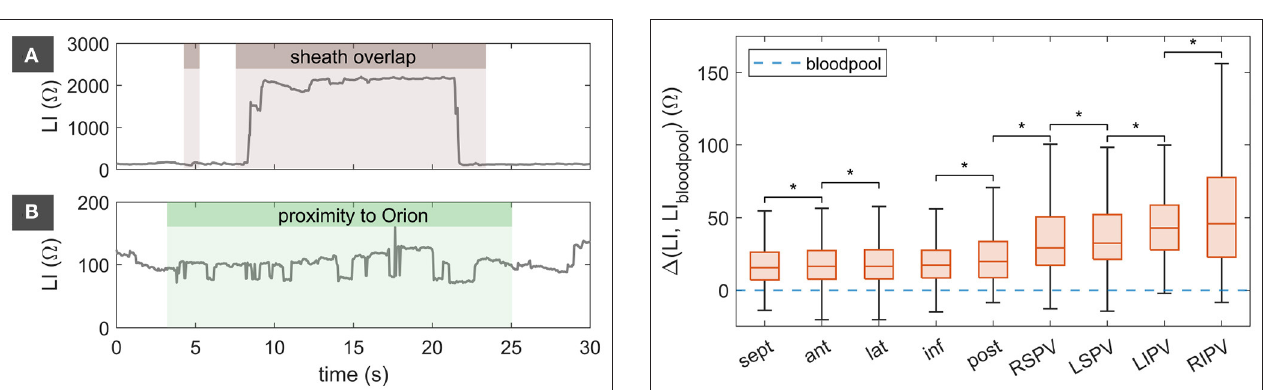
FIGURE 3 | LI raw artifacts attributed to an overlap with the steerable sheath in (A) as well as attributed to the proximity to the IntellaMap Orion TM catheter in (B) . Brown background marks samples that were excluded due to a suspected overlap with the steerable sheath. Green background marks samples that were excluded due to proximity to the IntellaMap Orion TM . LI, local impedance.